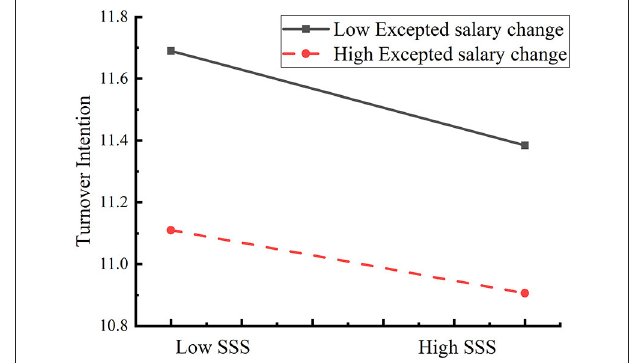
FIGURE 2 | Interaction between expected salary change on job